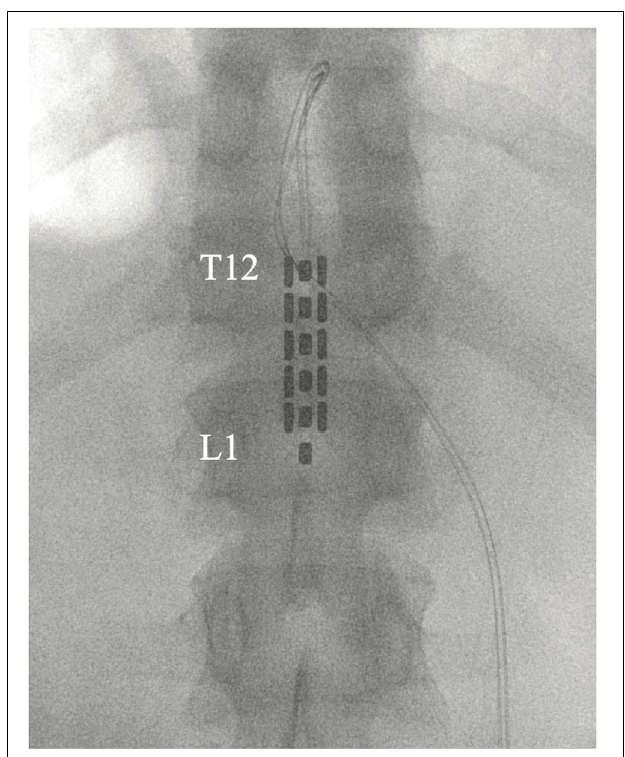
FIGURE 2 | Placement of 5-6-5 epidural paddle lead through a T12 laminectomy, overlying the T12–L1 epidural space. Final lead placement is guided by intraoperative electromyogram